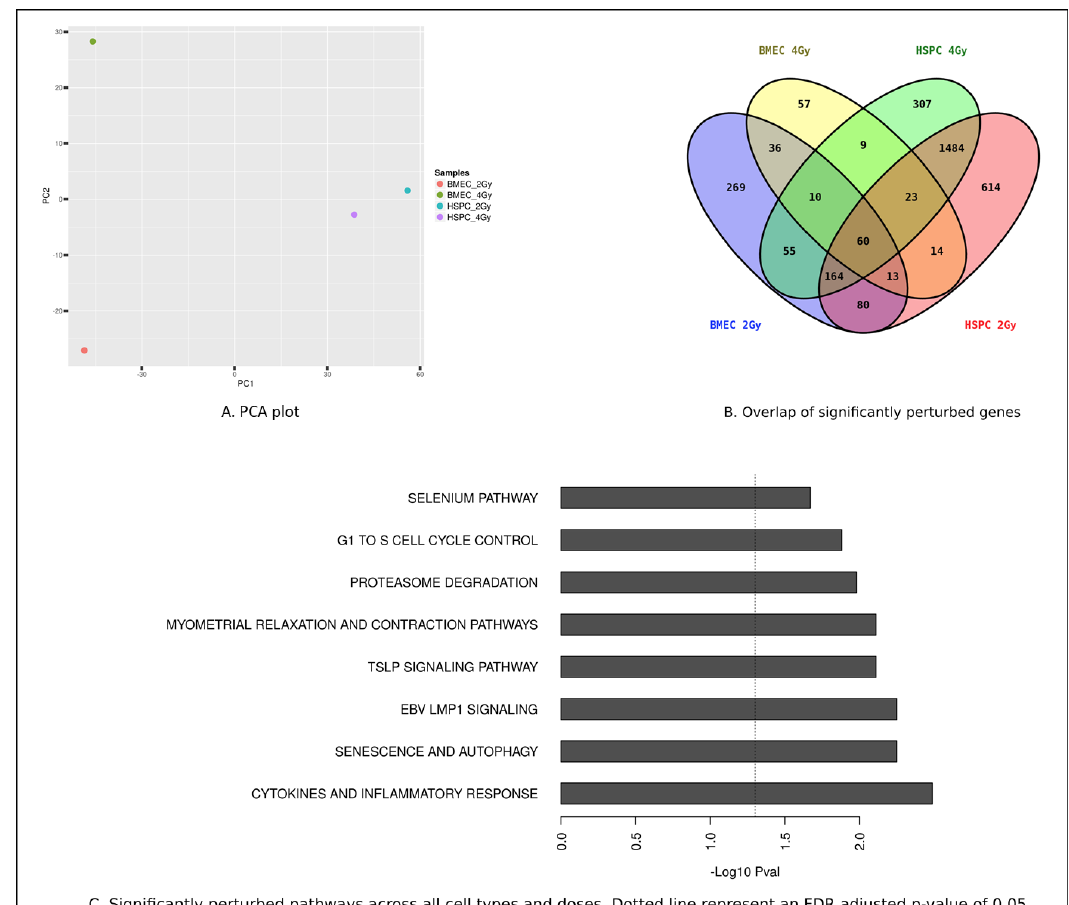
Figure 5. Bioinformatics analysis of HSPC and hBMEC in response to 2 Gy or 4 Gy MF radiation. ( A ) Principal component analysis plot ( B ) Overlap of significantly modulated genes, ( C ) Significantly perturbed pathways.